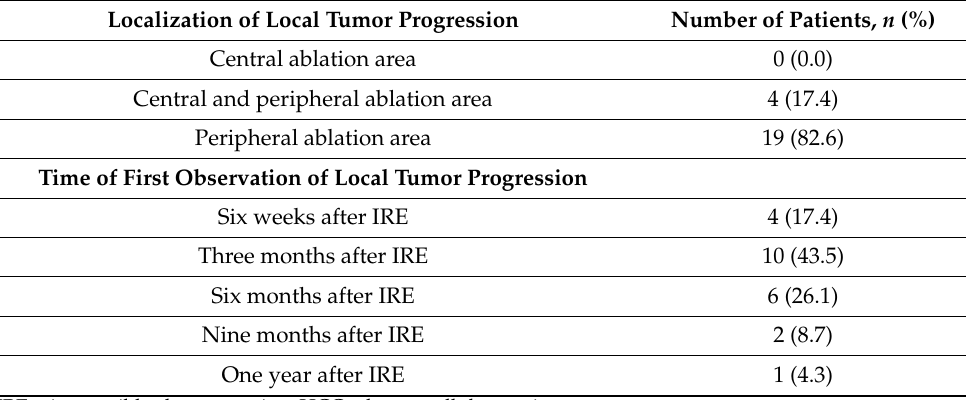
Table 3. Distribution of the local tumor progression after IRE of an HCC. Localization of Local Tumor